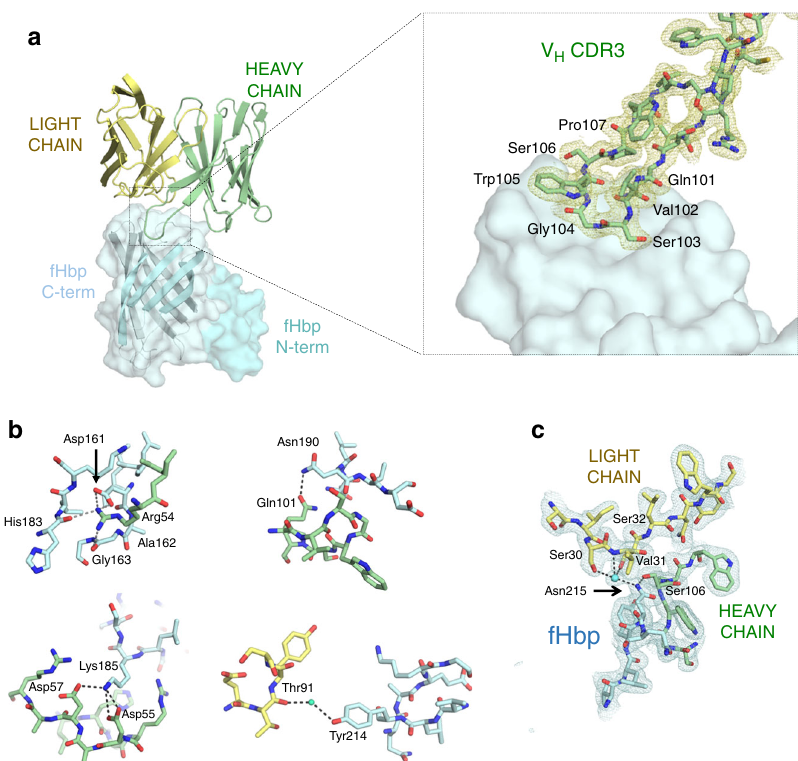
Fig. 4 Intermolecular interactions in the Fab 1A12/fHbp-binding interface. a Left: ribbon representation highlighting the region where the Fab V H CDR3 loop contacts fHbp. The N- and C-terminal domains of fHbp are displayed in surface mode in different blue palette colors; the Fab is colored as in Fig. 2. For clarity, the constant regions of the Fab have been omitted. Right: the V H CDR3 loop (stick bonds) and its 2Fo-Fc electron density map (yellow mesh) at 1 σ contour level. Fab constant regions are omitted for clarity. b Noteworthy salt bridges and other polar interactions at the binding interface, involving V H CDR2 and 3. (FHbp: cyan; Fab light chain: yellow; Fab heavy chain: green). c The binding interface centered around fHbp residue Asn215 is shown as sticks. Polar interactions ( ≤ 3.3 Å) established with the heavy and light chains are represented by dashed lines. The cyan sphere represents a water molecule. The blue mesh depicts the 2Fo-Fc electron density map associated with the region displayed, plotted at 1 σ contour level